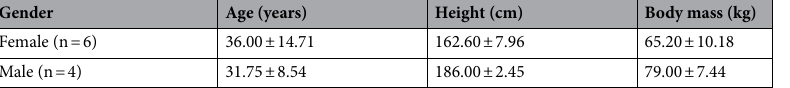
Table 1. Anthropometric data. Displayed are the arithmetic means and standard deviations (M ± SD) of age, height and body mass of the n = 10